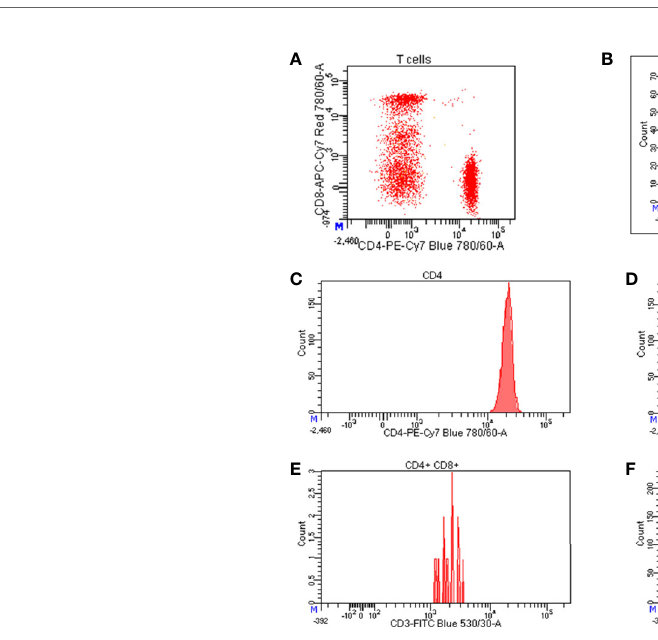
FIGURE 3 | Representation of fl ow cytometry data. (A) Bi-dimensional visualization of data (dot plot) where each axis represents an antigen; (B) histograms representing the expression level of CD8 on T cells; starting from left to right, the fi rst peak corresponds to CD8 negative T cells, the second peak represents cells expressing intermediate level of CD8, whereas the third peaks indicates highly positive cells for CD8 expression; (C) normal distribution of CD4 expression on CD4 positive cells; (D) bimodal distribution of CD4 expression on T cells where the peak on the left corresponds to CD4 negative T cells, while the peak on the right represents CD4 positive T cells; expression levels of CD3 on (E) a poorly represented cell population (CD4+CD8+ T cells) and (F) a well-represented cell population (T